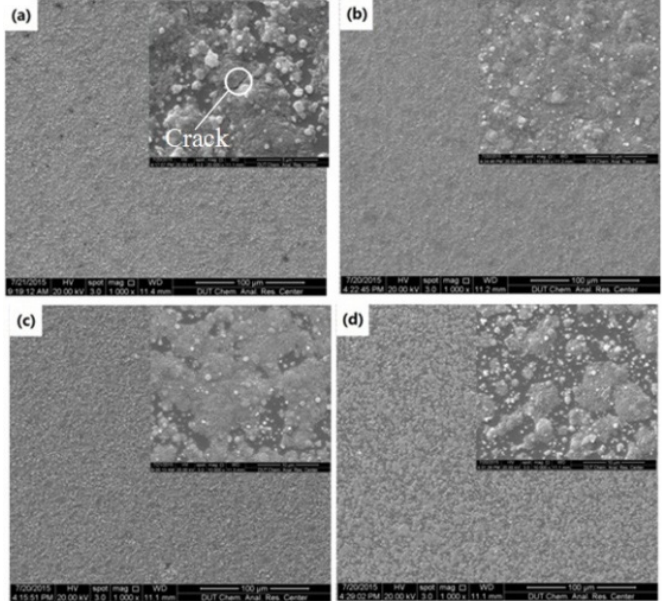
Figure 7. SEM images for two ‐ layer BTO thin film at 4 mm jet height with different line ‐ to ‐ line pitches: ( a ) 200 μ m, ( b ) 300 μ m, ( c ) 400 μ m and ( d ) 500 μ m.